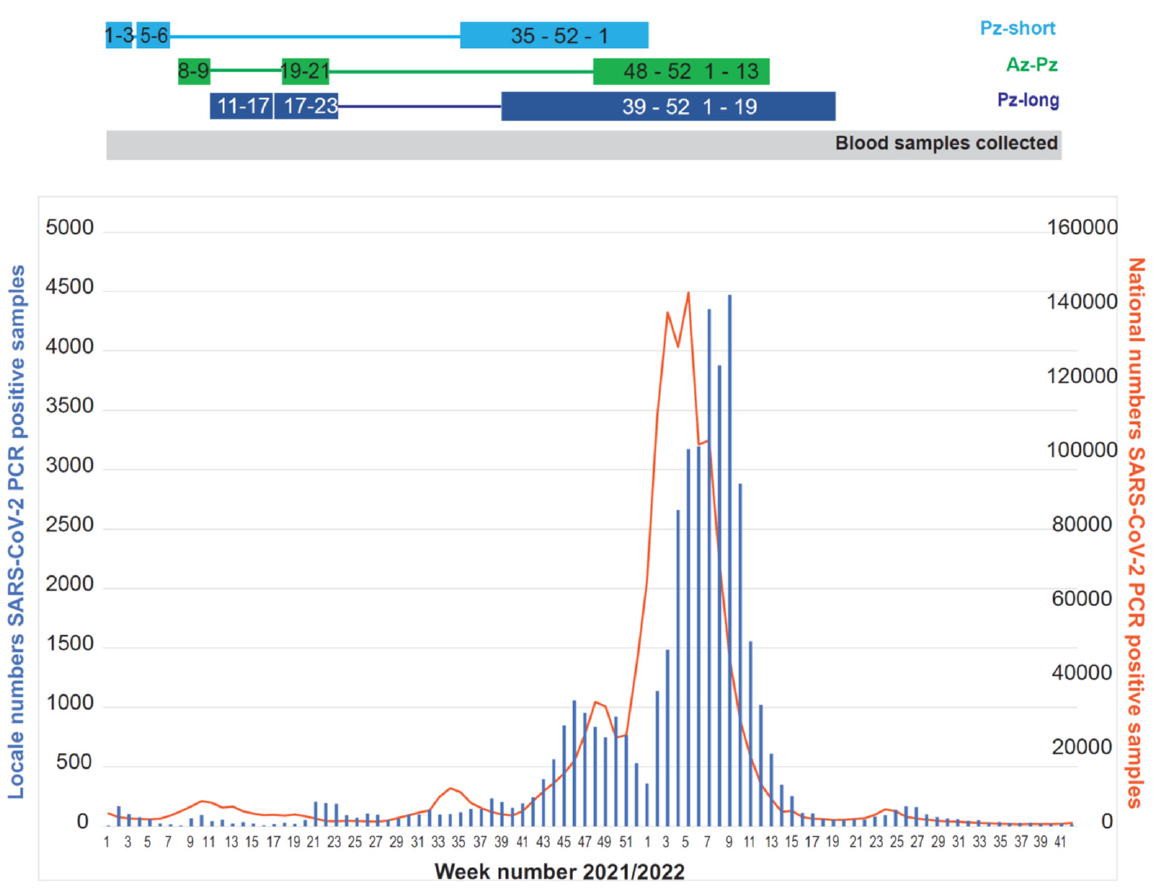
Figure 1. Timeline of the study. Upper part: time of vaccination. The Pz-short (light blue), Az-Pz (green) and Pz-long (dark blue) groups received three vaccine doses at different timepoints and intervals, illustrated by boxes with week numbers. Blood samples were collected from 1 January 2021 until 17 October 2022, i.e., week 1 of 2021 up to and including week 41 of 2022. Lower part: pandemic curve. Numbers of polymerase chain reaction (PCR) confirmed SARS-CoV-2 infections from our laboratory (blue bars) and total national numbers (orange graph) during the time of our study. At the beginning of the study, numbers of diagnosed infections were low but peaked during the period in which the third dose was administered.